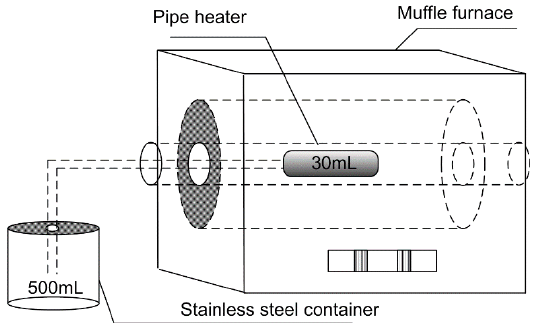
Figure 1. Sketch of thermal faults simulation system.